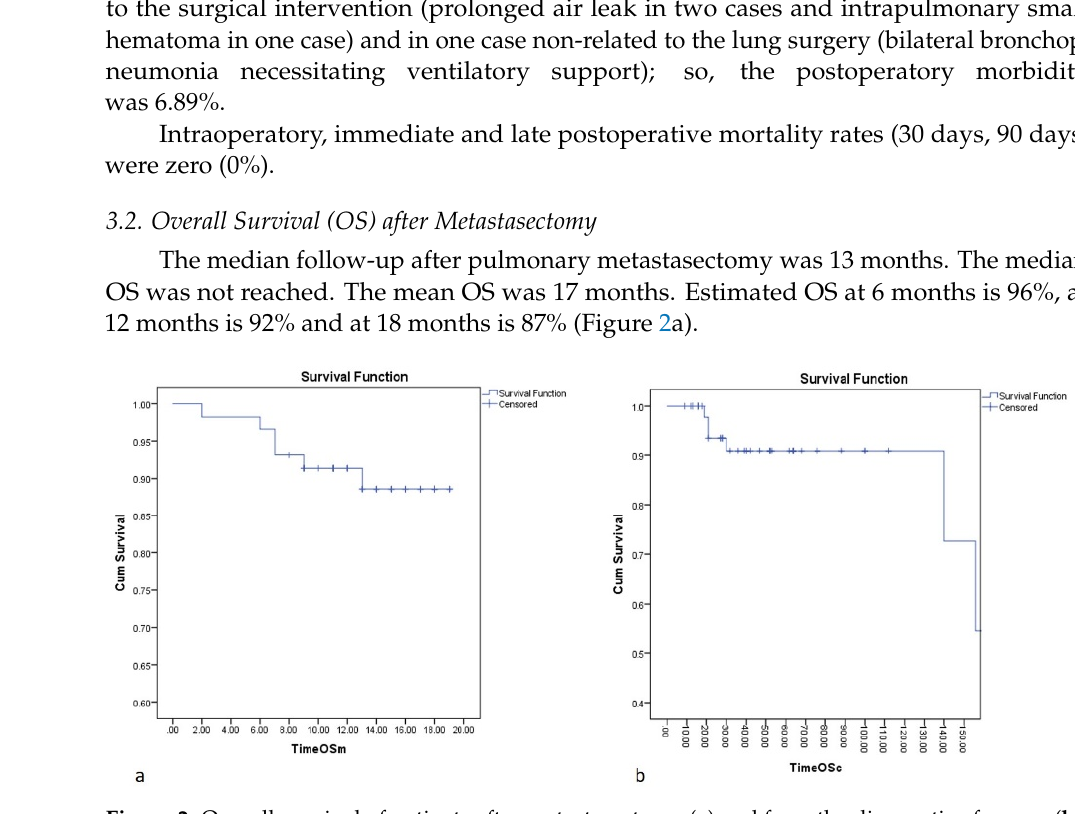
Figure 2. Overall survival of patients after metastasectomy ( a ) and from the diagnostic of cancer ( b ). Overall survival for cancer results are: the median OS is 149 months. A 5 years